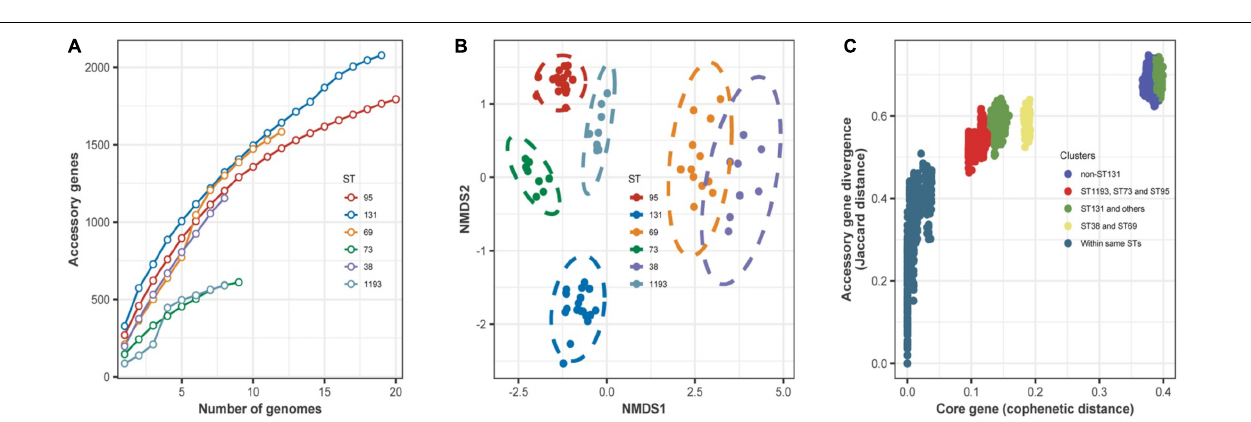
FIGURE 3 | Minimum spanning tree based on the core genome of 148 E. coli isolates from patients with EC-COBSI. Colors indicate the classical multilocus STs. According to the framework for interpreting SNP analysis from the FDA-CFSAN, isolates were considered closely related based on the likelihood they arose from the same source when assessing the SNP results. A SNP distance of 10 or less to the nearest neighbor was considered presumptive transmission.